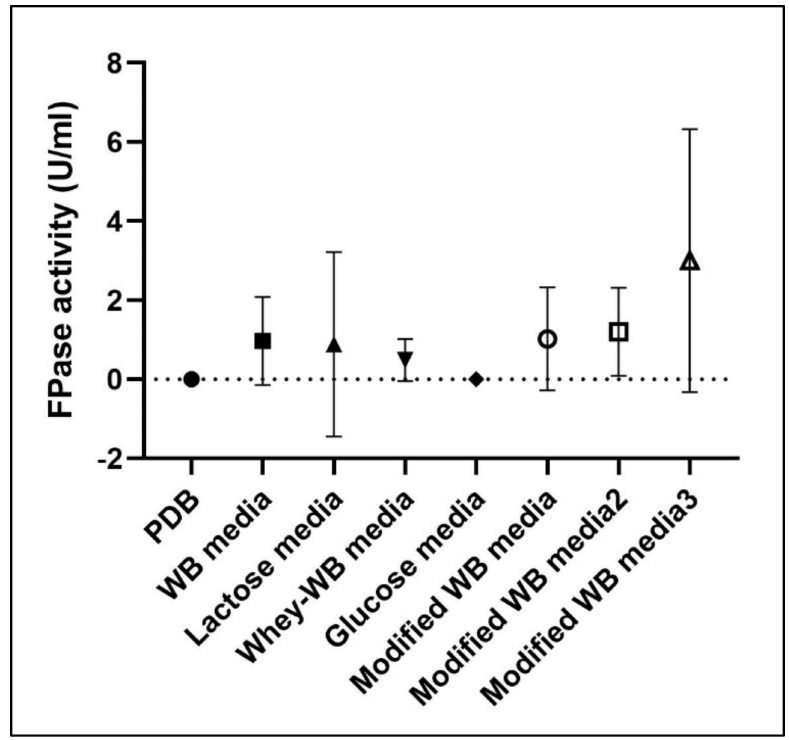
Figure 3. Total cellulase activity (FPase) in different production